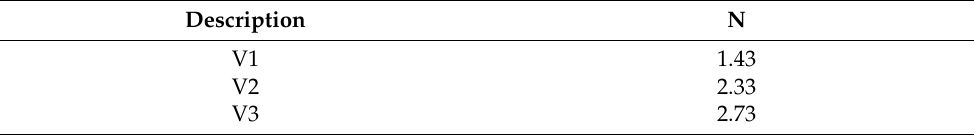
Table 3. The fitting parameter N extracted from the QPC model fit for LRS